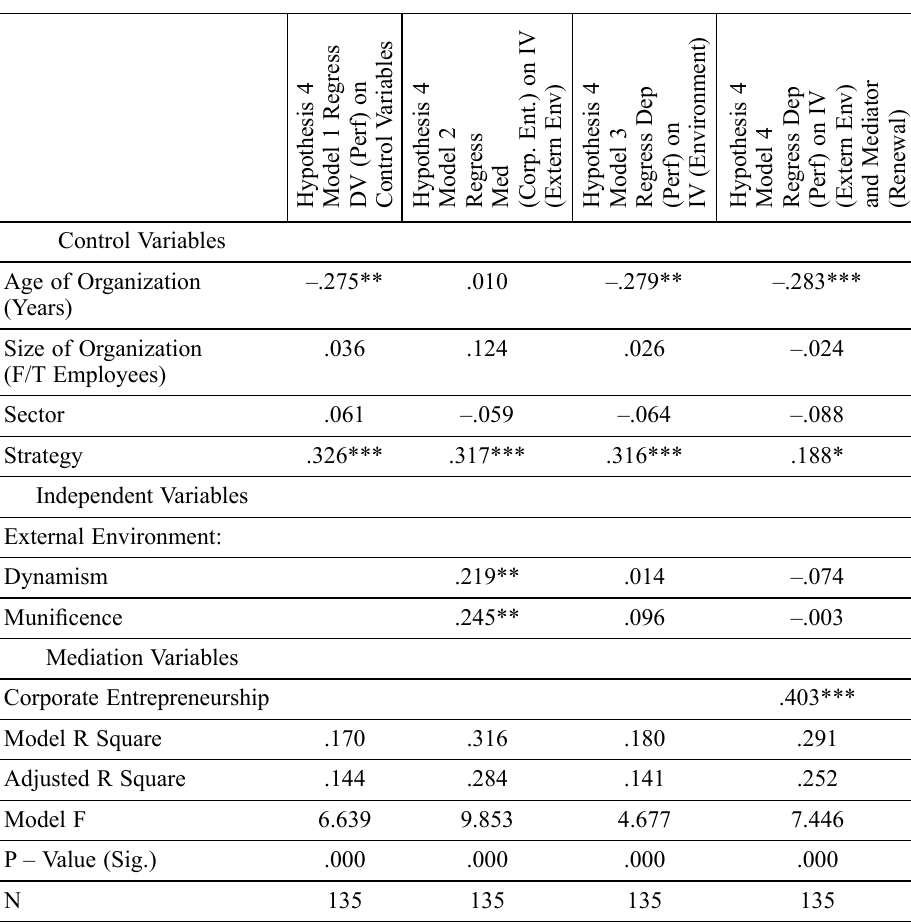
Table 8. Hierarchical regression analysis results – hypothesis four (private sector, Slovenia – mediation